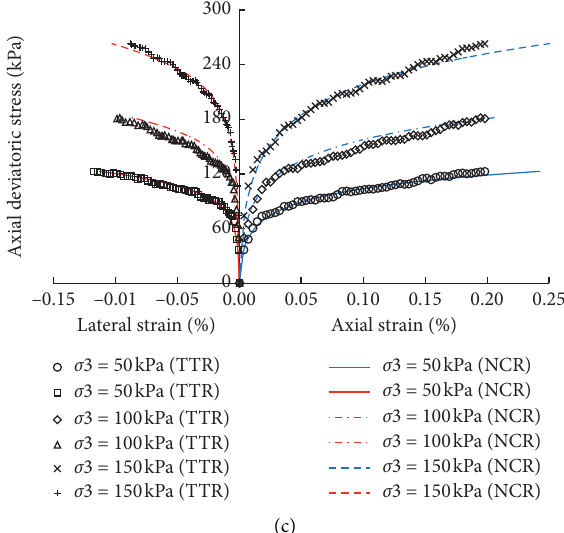
Figure 11: Comparison between numerical calculation results and triaxial test results: (a) degree of compaction is 90%; (b) degree of compaction is 93%; (c) degree of compaction is